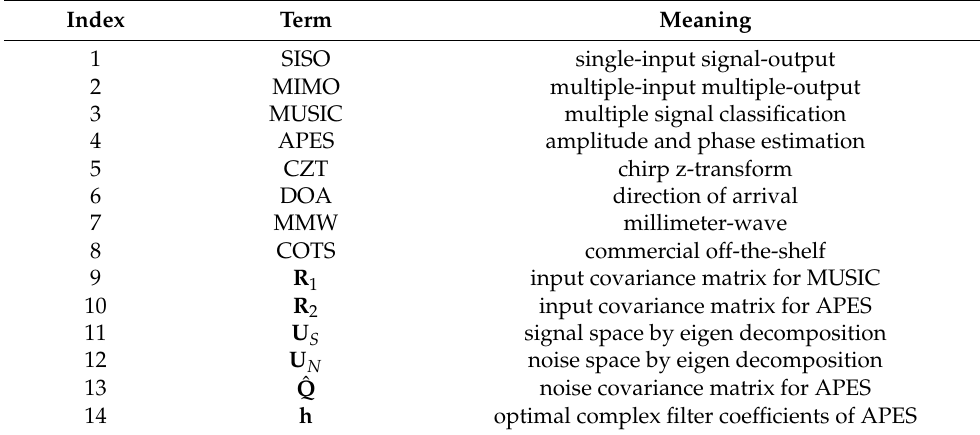
Table 1. Meanings of main abbreviations, acronyms and symbols.